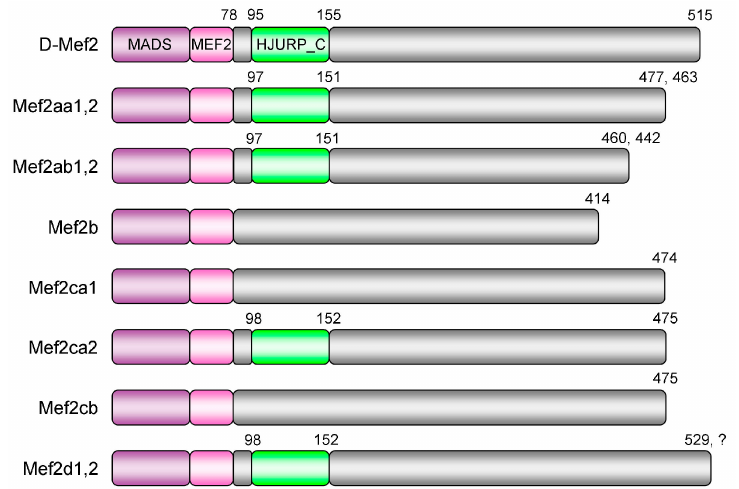
Figure1. Domainstructureof Cyprinuscarpio Mef2(myocyteenhancerfactor2)proteins. The N-terminal region of each Mef2 protein harbors the evolutionarily conserved MADS-box and MEF2 domains. The third homologous structure located in the highly variable C-terminal region, namely the HJURP_C domain, is not identified in Mef2b, Mef2ca1, and Mef2cb by Conserved Domain Search. The numbers indicated are amino acid positions of one isoform. D-Mef2 represents the Mef2 protein of Drosophila melanogaster . The ohnologs with the same structural feature are labeled together as "1,2". The question mark denotes that the protein sequence of Mef2d2 is incomplete at